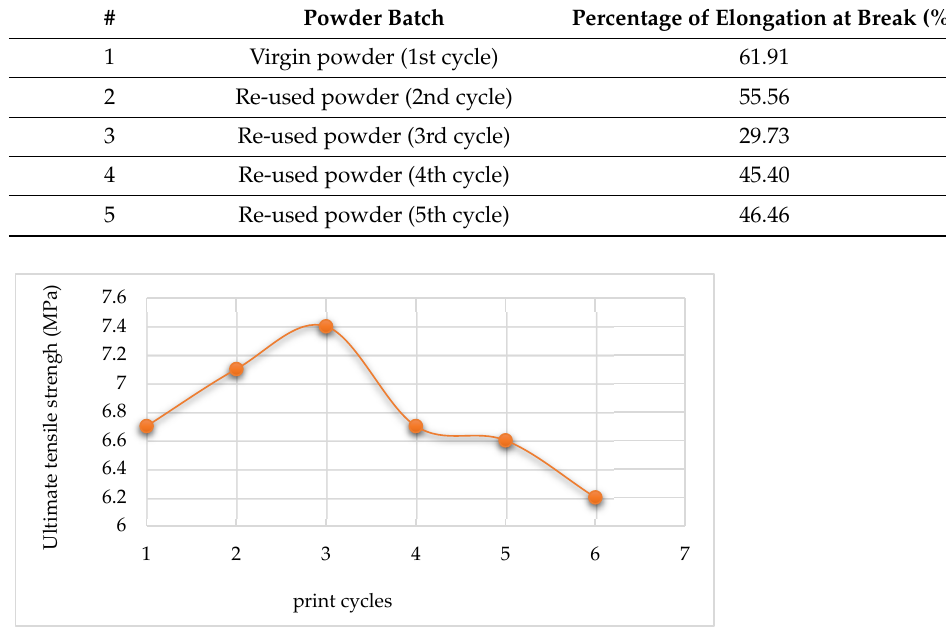
Table 12. Percentage of elongation at break of printed parts after 100% re-use.